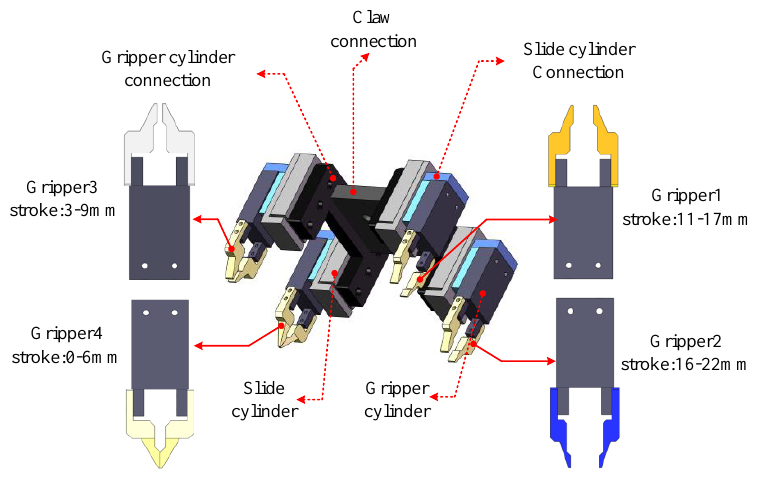
Figure 4. Robot flexible multi-gripper claw.